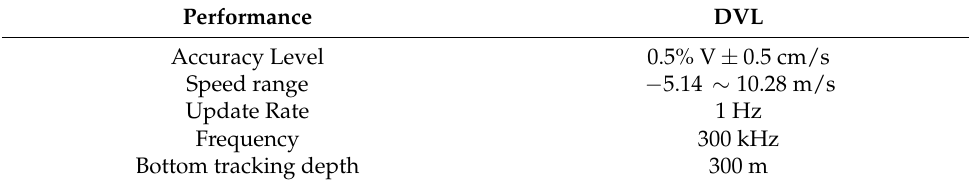
Table 5. The performance of DVL.